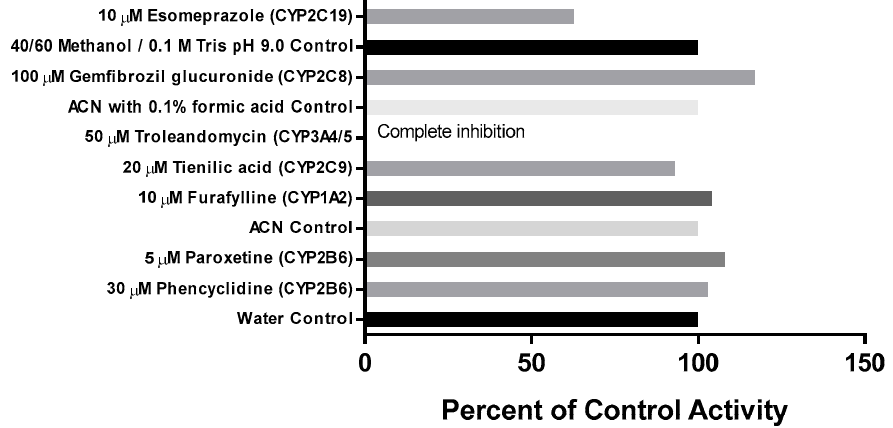
Figure 4. Effect of metabolism-dependent chemical inhibitors on the loss of CRV431 (1 µ M) by human liver microsomes after 30-min preincubation.